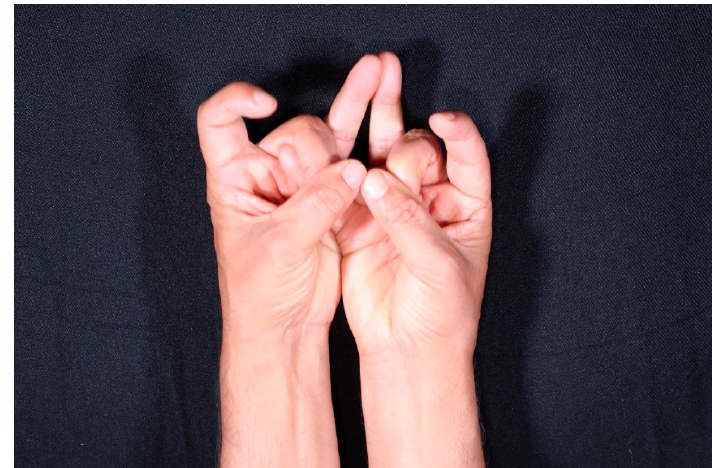
Religions 2021 , 12 , x FOR PEER REVIEW